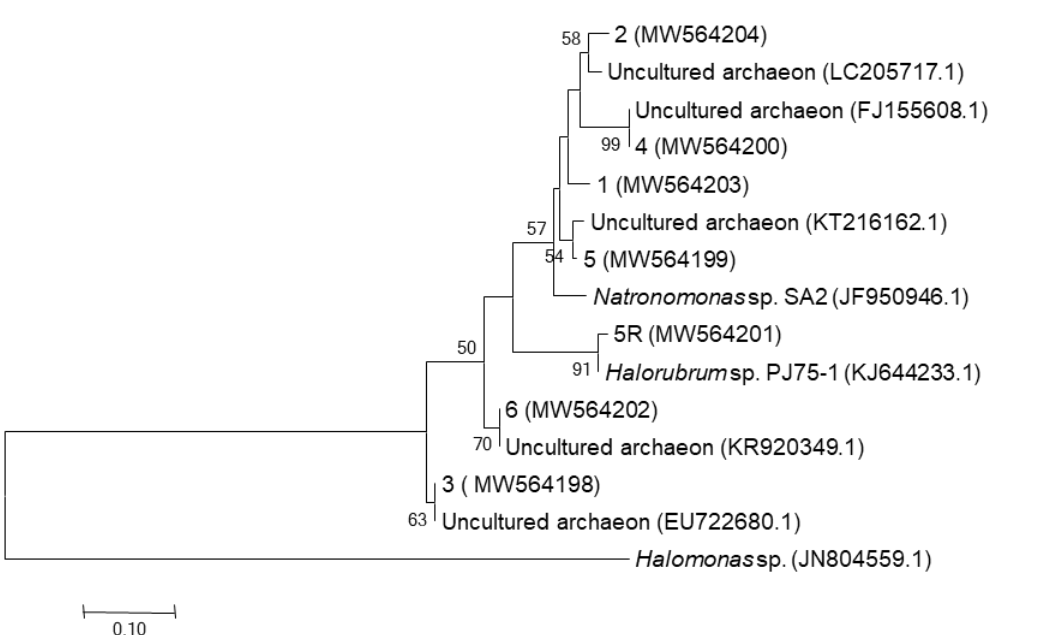
Table 3. Operational Taxonomic Units (OTUs) classification and affiliation of 16S rRNA gene clone sequences of CDW, CDR, and CDZ halite-salt crystals samples based on RDP II database (Accession no. Deposited) Sampling Site: CDR Total OTUs (0.03